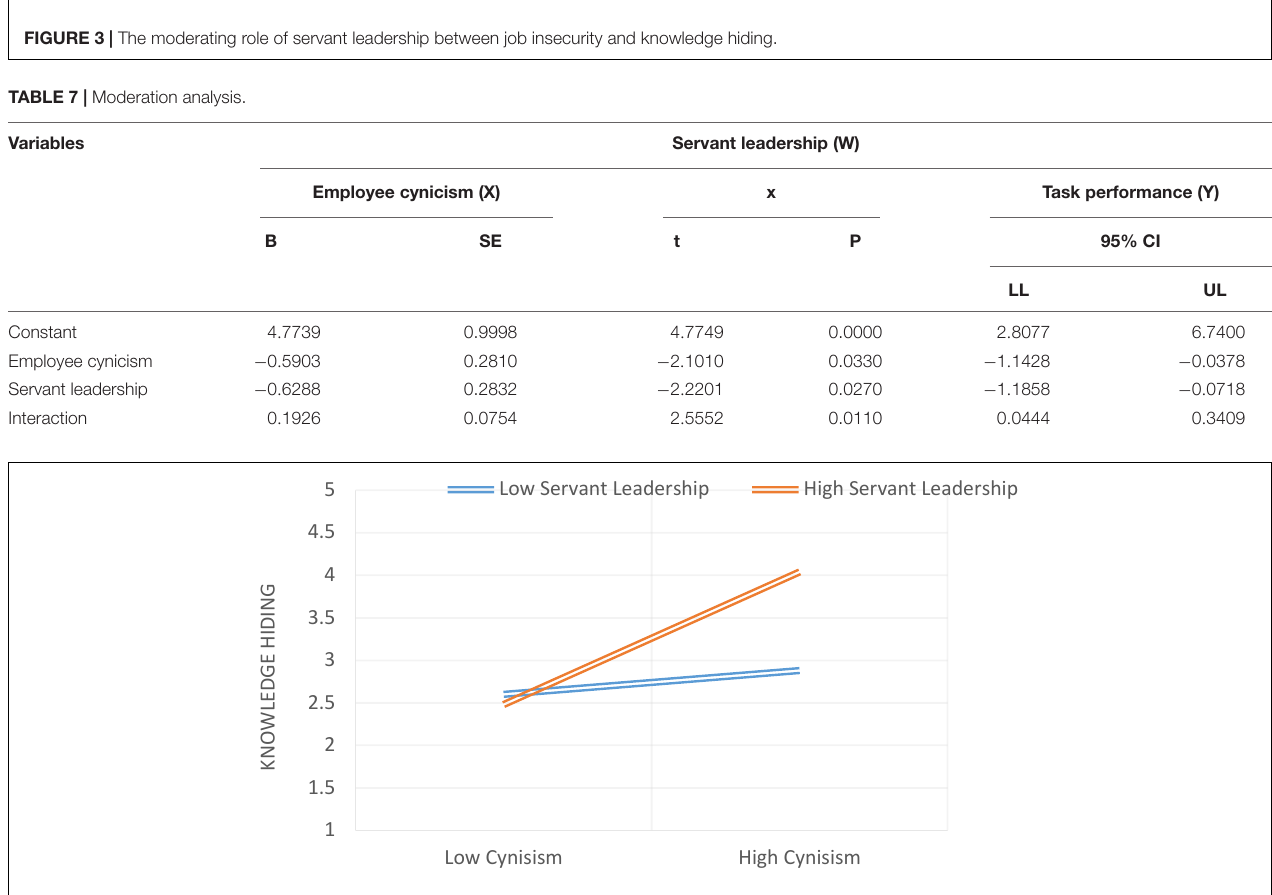
FIGURE 4 | The moderating role of servant leadership between cynicism and knowledge hiding.